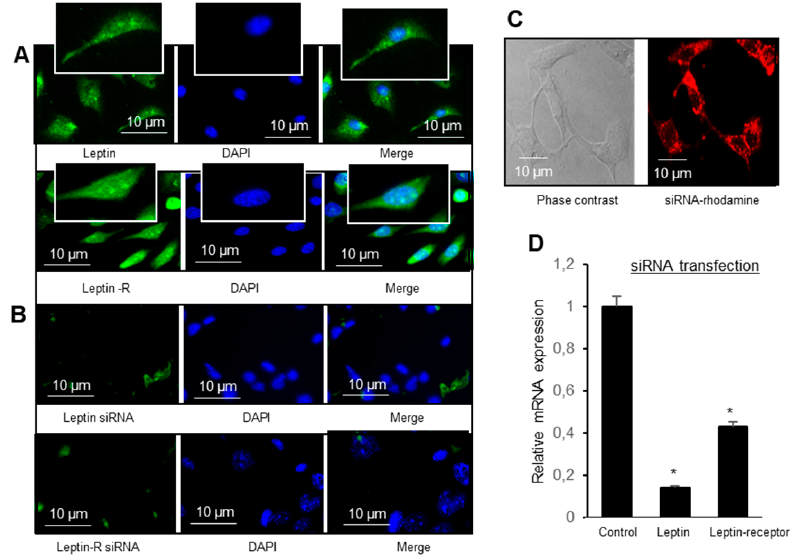
Figure 2. Expression of leptin and leptin receptor (Ob-Rb) in mice TBC. ( A ) Immunostaining of leptin and leptin receptor, leptin-R, (green in ( A )), in cultured TBC, were acquired through fluorescent microscope, nuclei of the cells were stained with DAPI. ( B ) shows the absence immunostaining of leptin and leptin-R in TBC after their siRNA application onto mice tongue. ( C ) shows the incorpo- ration of non-targeting siRNA (labeled with DY-547) by mouse TBC. ( D ) shows leptin and leptin-R mRNA expression after application onto the tongue of their respective siRNA. The asterisks in D show significant values ( p < 0.001) compared to control group.